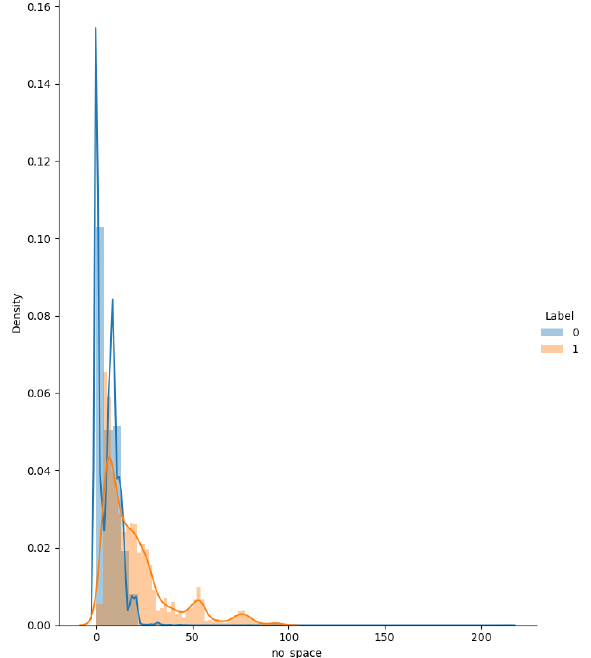
Figure 10. The distribution of feature 8. The horizontal coordinate indicates the number of spaces in the SQL query, and the vertical coordinate indicates the corresponding probability density function. The blue line indicates benign samples and the orange line indicates malicious samples. As can be seen, queries with the number of spaces after 25 have a high probability of becoming malicious.